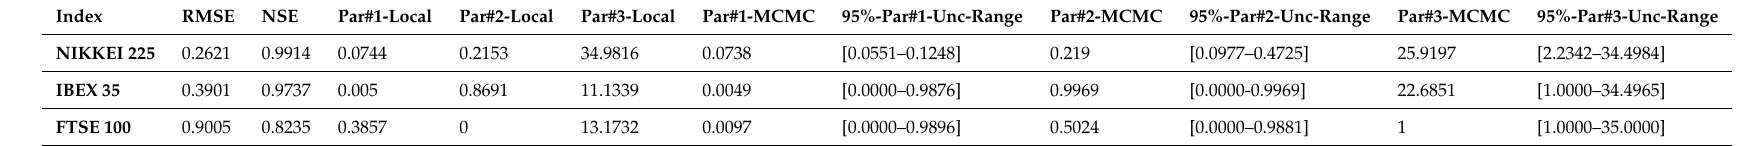
Table 6. Tawn copula parameters estimation: NIKKEI225, IBEX35, and FTSE100